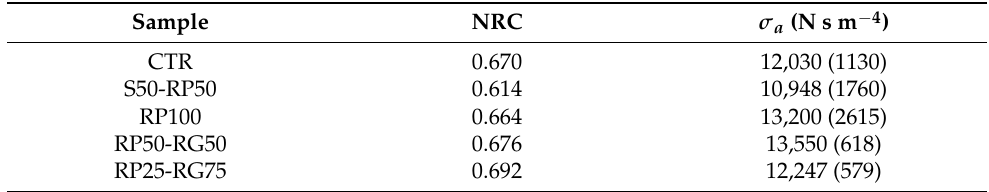
Table 3. Noise reduction coefficient and acoustic flow resistivity (standard deviations in round brackets): test results.